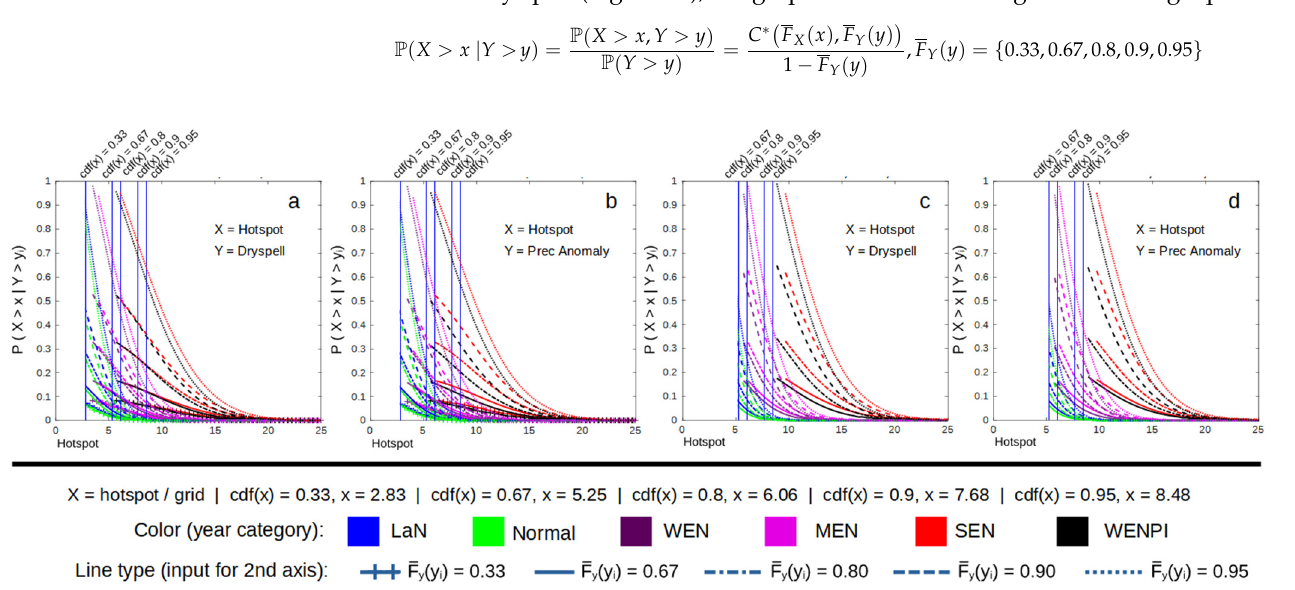
Figure 5. Conditional survival probability of hotspot when the climate ( a . dry spell, b . prec. anomaly) conditions are at least in normal conditions and when ( c . dry spell, d . prec. anomaly) conditions are in dry conditions for 2001–2020 data.